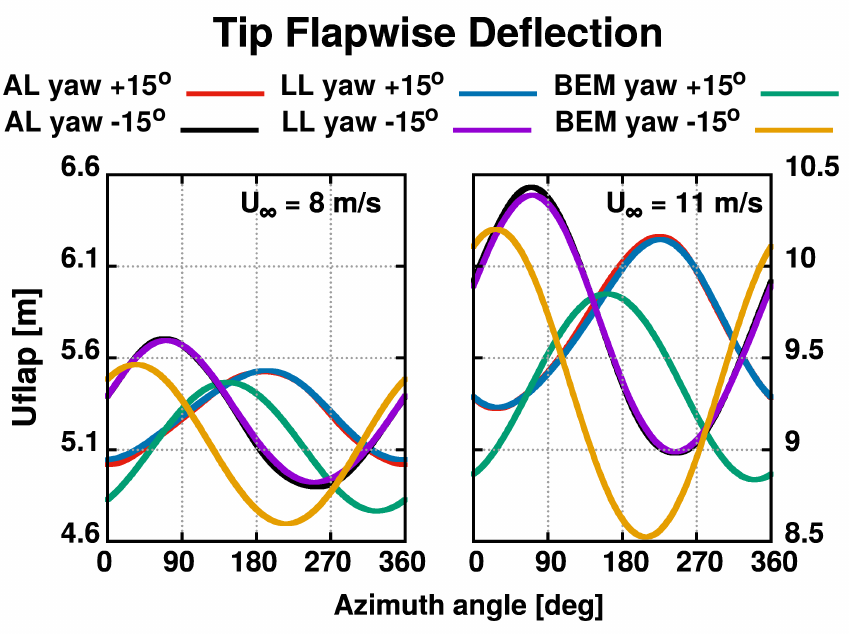
Figure 25. Out-of-plane deflection of blade tip at 15 ◦ yawed wind speed at 8 and 11 m/s.